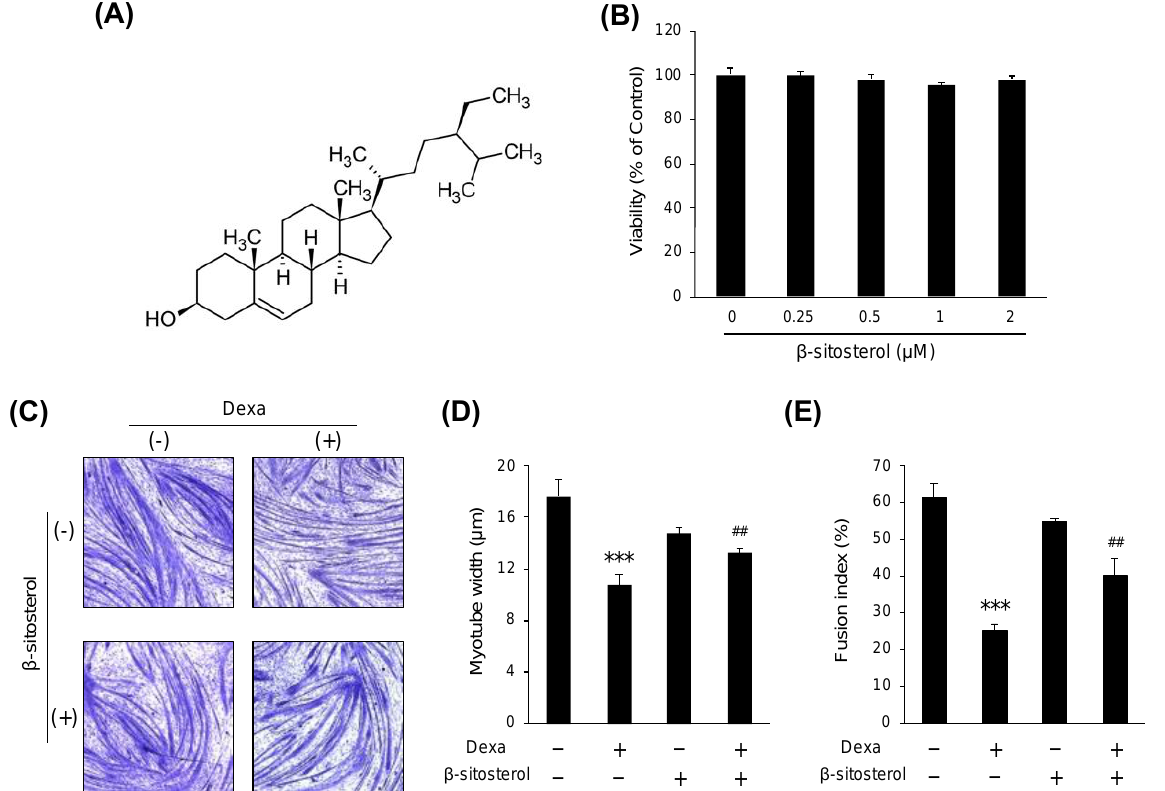
Figure 3. β -sitosterol attenuates Dexa-induced muscle atrophy in C2C12 myotubes. ( A ) Chemical structure of β -sitosterol. ( B ) C2C12 cells were cultured in medium with various concentrations (0.25, 0.5, 1, and 2 mM) of β -sitosterol for 24 h. Cell viability was measured by a CCK-8 assay. The viability of control (untreated cells) was set to 100%. Viability as a percentage of that of control cells is shown. Bars represent the mean ± S.D. ( n = 4 per treatment). ( C ) May–Grunwald and Giemsa staining. The cells were incubated with 0.5 mM β -sitosterol for 48 h in the presence or absence of 1 µ M dexamethasone (Dexa) for 48 h. ( D ) Quantification of myotube widths from May–Grunwald and Giemsa stained images. Data shown are mean ± S.D. ( n = 100). *** p < 0.001 vs. untreated control; ## p < 0.01 vs. Dexa. ( E ) Fusion index. The total number of nuclei incorporated in myotubes and the total number of nuclei were scored. Fusion index was calculated as the percentage of total nuclei incorporated in myotubes. *** p < 0.001 vs. untreated control, ## p < 0.01 vs. Dexa. DS—dexa + β